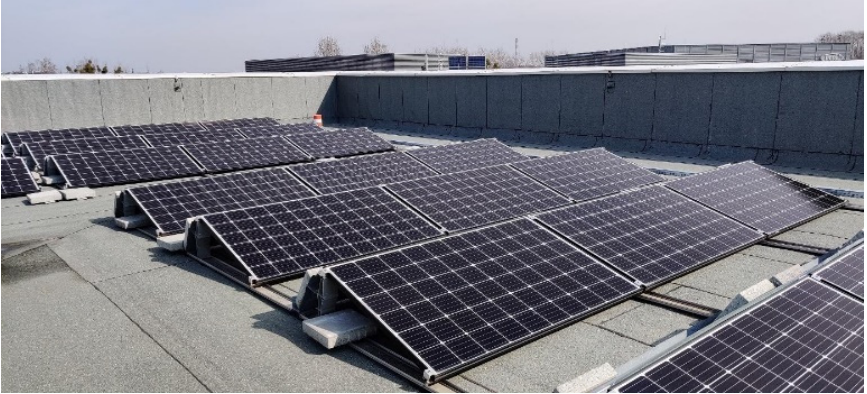
Figure 8. Photo of PV cells on the roof.